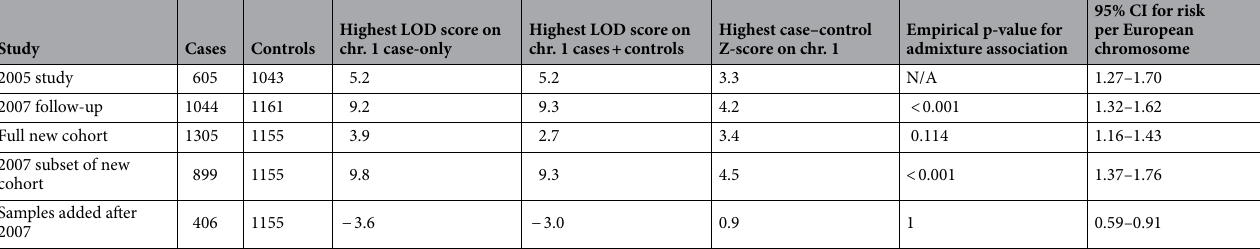
Table 1. Admixture association scores on chromosome 1 in different sample sets. The highest LOD score results are computed by ANCESTRYMAP based on a prior on relative risk per European ancestry allele of 1.5. The 95% confidence intervals for risk per European allele are obtained by running on a uniformly spaced grid of models from 0.5 to 2.0-fold per European allele, assuming an equal prior probability of risk for each, and then taking the LOD score to the power of 10 and normalizing to obtain a posterior. The LOD scores for the grid of models for the 2005 study are from the original publication 11 ; all LOD scores are given in Supplementary Table S3. Empirical p-values were found through permutation analysis; see “Materials and methods” section. p-values were listed as < 0.001 when 0 of the 1000 permutations had a score at least as large as that of the LOD score of that data